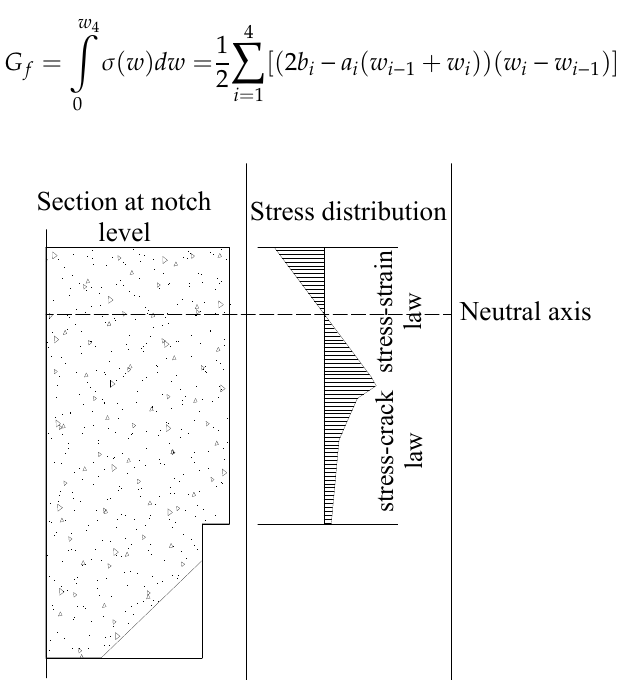
Figure 2. Stress distributions at the notch section.